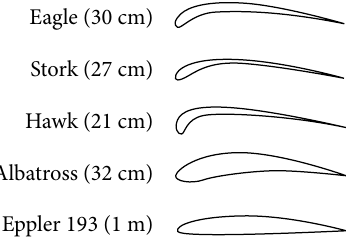
Figure 1. Shape and chord length for the